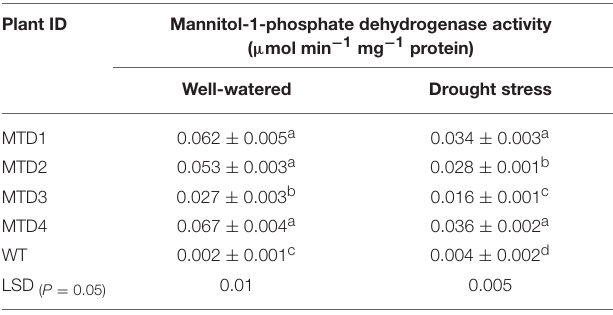
TABLE 1 | Comparison of mannitol-1-phosphate dehydrogenase activity of WT and transgenic lines at 24 days under well-watered and drought stress conditions. Plant